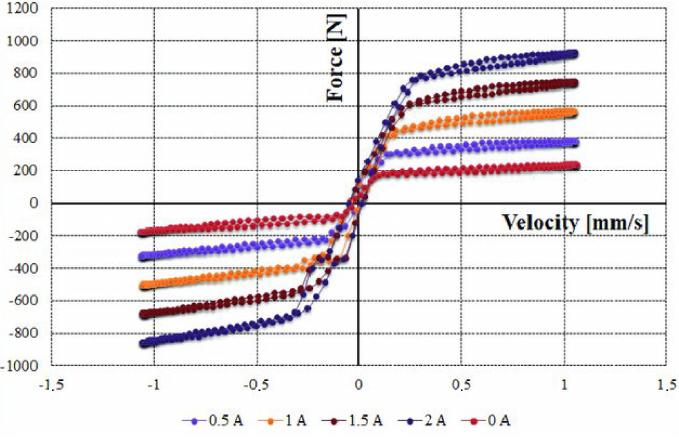
Figure 2. Force–deflection velocity characteristic of MR damper